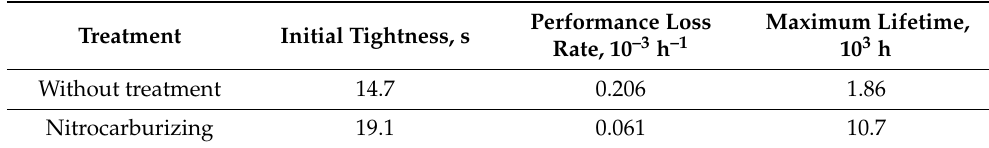
Figure 13. Lifetime evaluation for the untreated and nitrocarburized valves. Table 7. Results of the regression analysis,